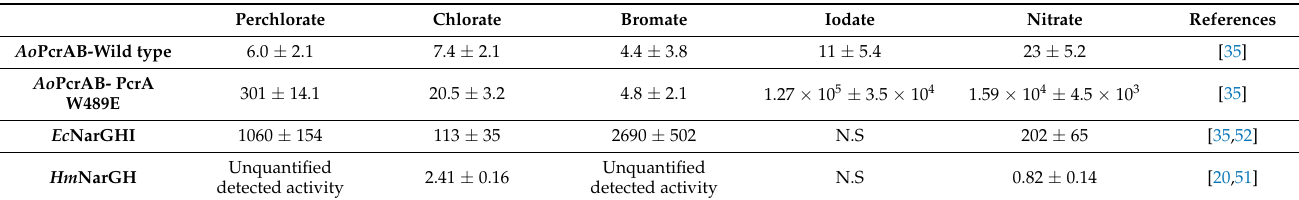
Table 1. Michaelis constant (K m , mM) comparison for Ao PcrAB-Wild type and Ao PcrAB-PcrA W489E from Azospira oryzae , Ec NarGHI from Escherichia coli and Hm NarGH from Haloferax mediterranei . N.S means not a substrate.